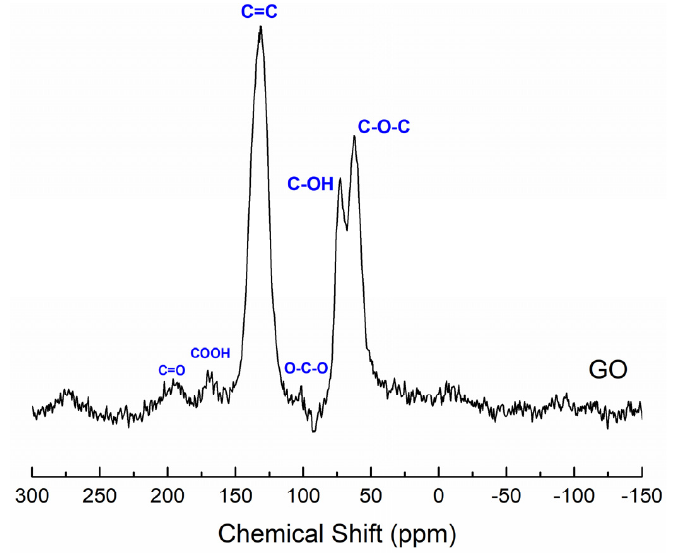
Figure 4. Solid-state 13 C NMR spectrum obtained for the GO sample.